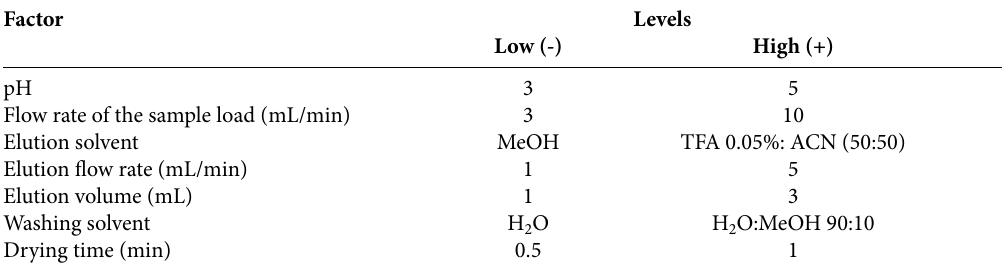
Table 3. Factors considered in the extraction process and levels of variations carried out in the experiments